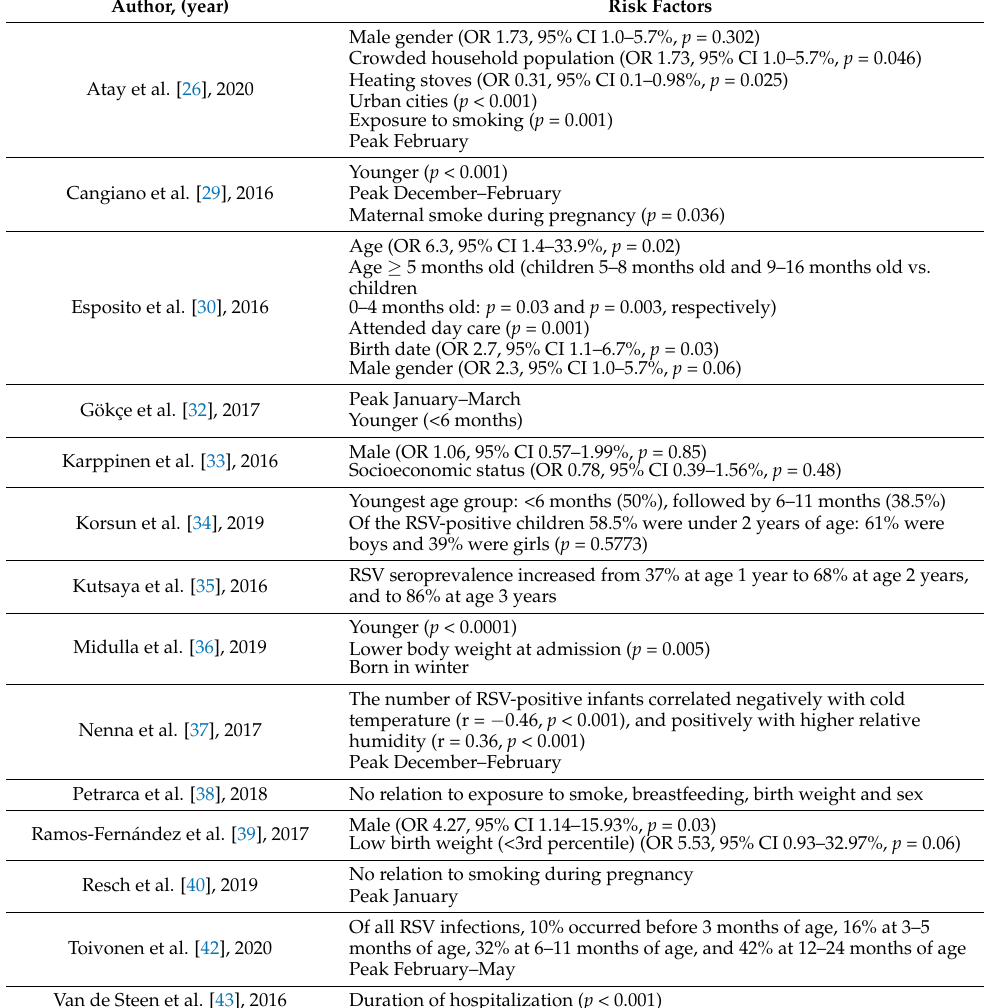
Table 2. Main risk factors associated with RSV